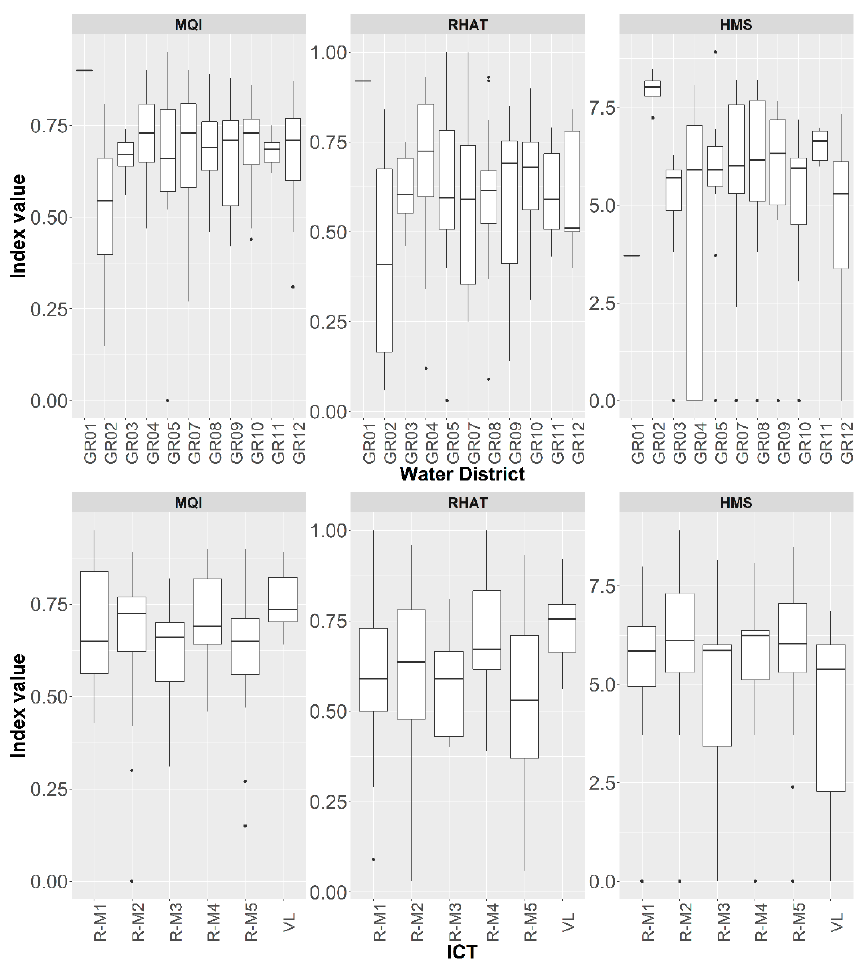
Figure 4. Box plots of MQI, RHAT and HMS per water district and intercalibration river type (ICT). HMS values have been ln transformed.